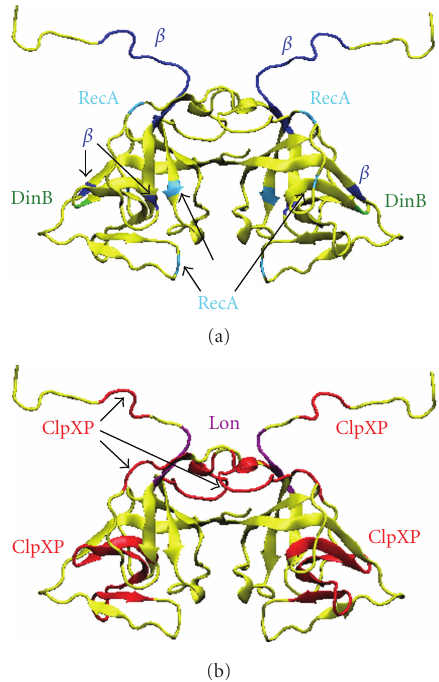
Figure 3: Protein interaction sites on UmuD. (a) The β clamp interacts with residues 14–19, 24, 52, and 126 (blue) [53]. RecA interacts with residues 34, 81, 57, 67, and 112 (cyan) [49]. DinB interacts with residue 91 on UmuD (green) [30]. (b) ClpXP interacts with residues 9–12, 33–37, 41–51, and 85–109 (red) [123]. Lon binds to regions close to the residues that are important for interaction with ClpXP, residues 15–19 (violet)